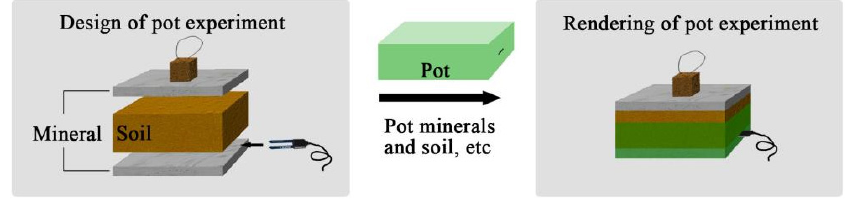
Figure 1. The design of the pot experiment. #2 is filled with a soil sample between two mineral samples. The upper mineral sample has a pull ring on the outer side. The soil moisture sensor (EC-5) is inserted at the interface between the lower mineral sample and the soil sample. The samples are placed in a pot and aseptically incubated.